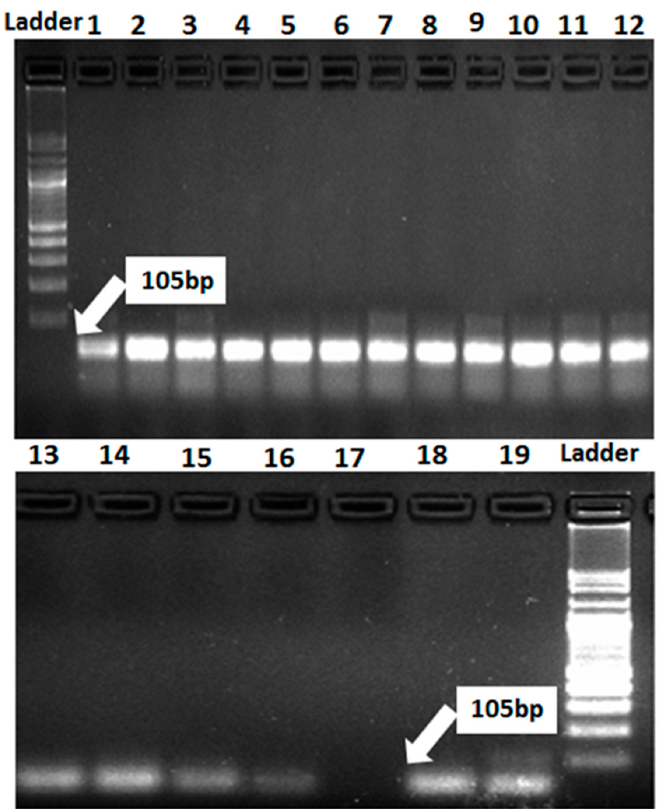
Figure 6. Electrophoretic amplified pattern of DNA extracted from 19 wheat genotypes using the specific primer of Lr46/Yr29 . Lane 1 = Misr-3, Lane 2 = Misr-4, Lane 3 = Misr-2, Lane 4 = Misr-1, Lane 5 = Sids-13, Lane 6 = Gemmeiza-9, Lane 7 = Gemmeiza-12, Lane 8 = Sakha-94, Lane 9 = Sakha-95, Lane 10 = Giza-168, Lane 11 = Gia-171, Lane 12 = Giza-139, Lane 13 = Sids-12, Lane 14 = Sakha-61, Lane 15 = Sids-14, Lane 16 = Gemmeiza-5, Lane 17 = Gemmeiza-7, Lane 18 = Gemmeiza-10, and Lane 19 = Shandweel-1.